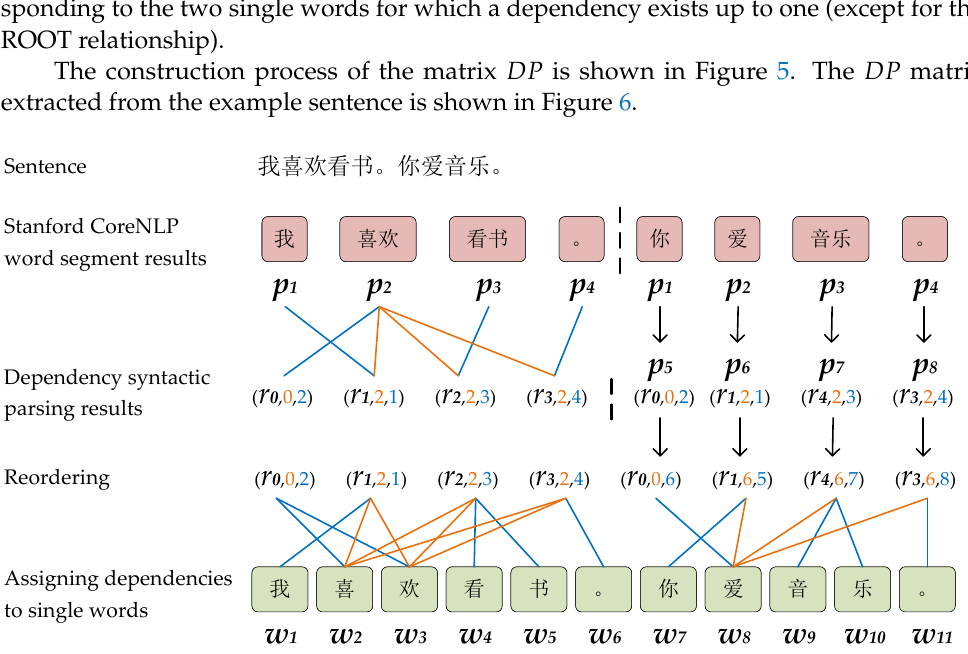
Figure 5. Dependency syntactic parsing and processing of the example sentence. The figure shows the Chinese example sentence going through the process of word segmentation, dependent syntax analysis, clause reordering and finally assingning dependent relationships to signal word